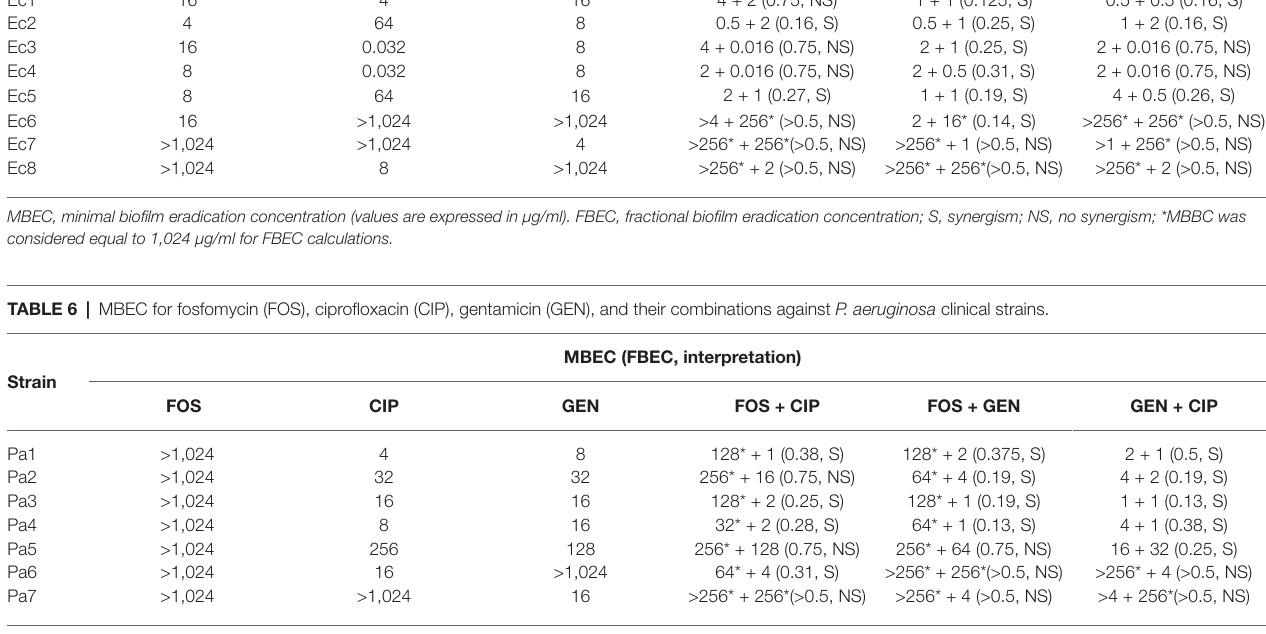
TABLE 5 | MBEC for fosfomycin (FOS), ciprofloxacin (CIP), gentamicin (GEN), and their combinations against E. coli clinical strains. Strain